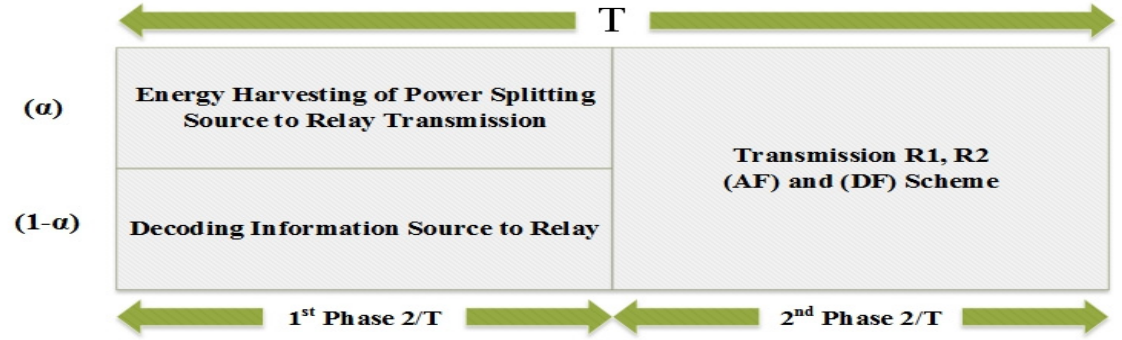
Figure 2. Power-splitting-, Energy-Harvesting- and time-switching-based relaying protocol. In this equation, the energy harvested from R 1 and R 2 is expressed as.